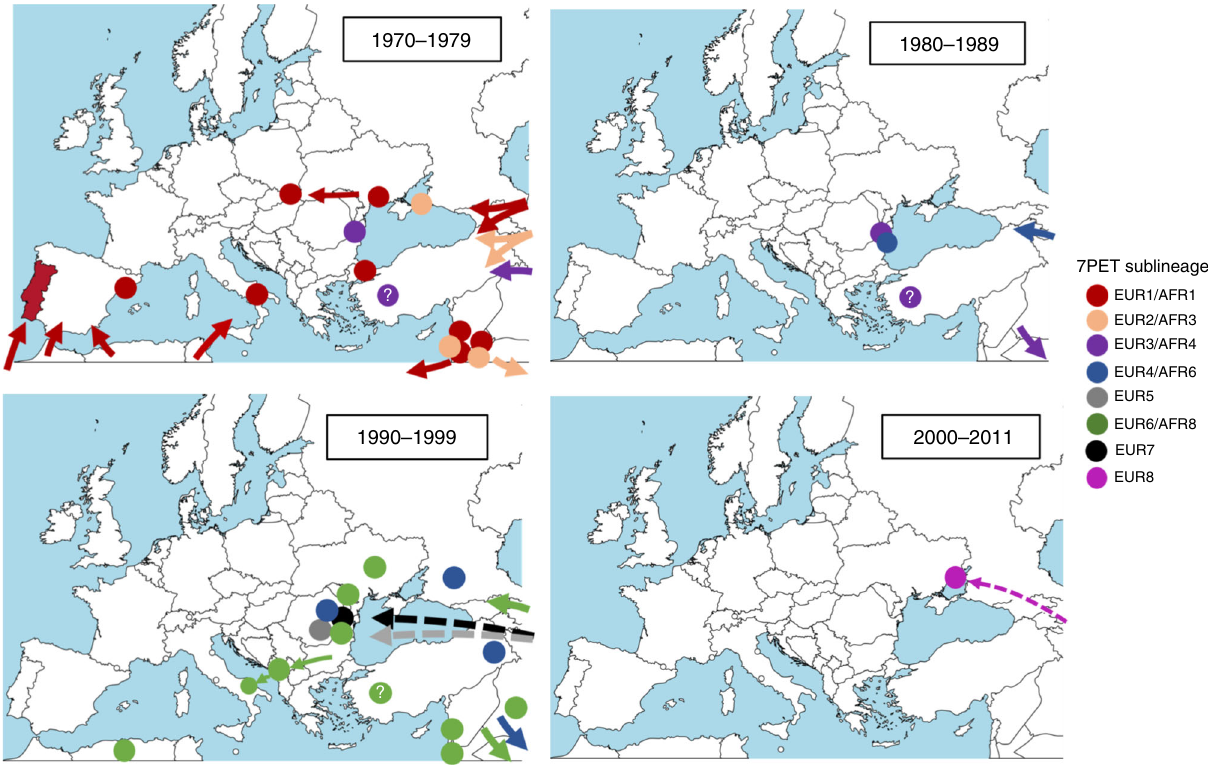
Fig. 2 Inferred propagation routes of seventh pandemic V. cholerae O1 El Tor populations to, from and within Europe between 1970 and 2011. The circles indicate the location within the country from which outbreak isolates were obtained. A question mark within the circle indicates that the precise site of origin within the country is unknown. The seventh pandemic V. cholerae O1 El Tor (7PET) sublineages are indicated by different colors. Arrows, particularly dashed arrows, represent approximate and not precise routes of propagation. The maps were created with mapchart.net (https://mapchart.